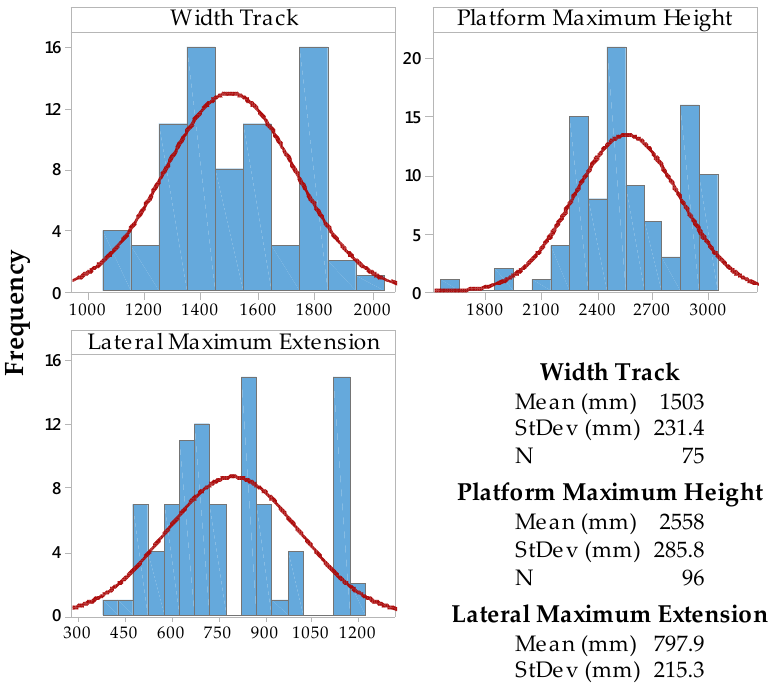
Figure 5. Descriptive statistics of the collected dataset.